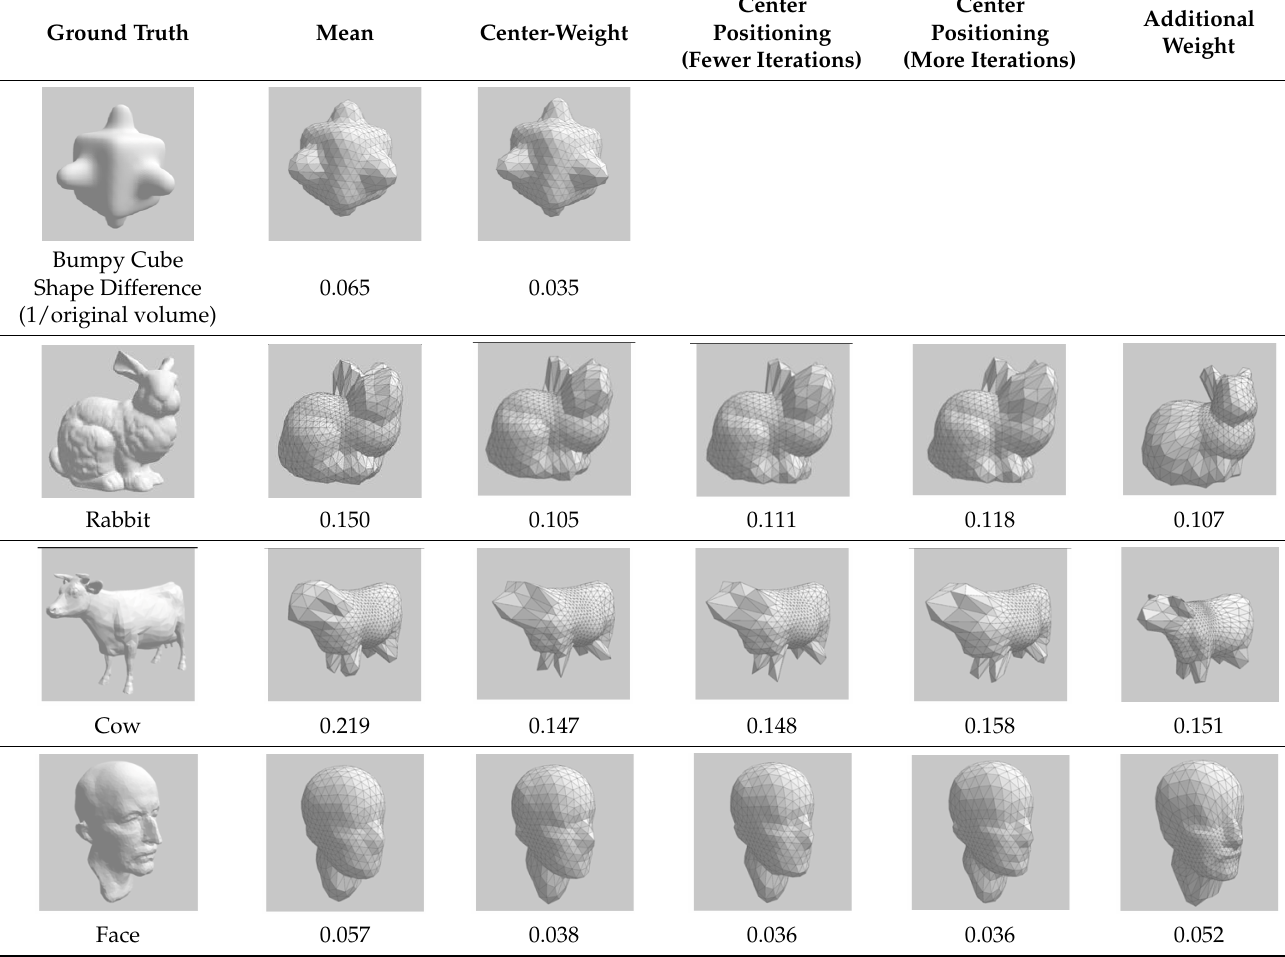
Additional (More Iterations)